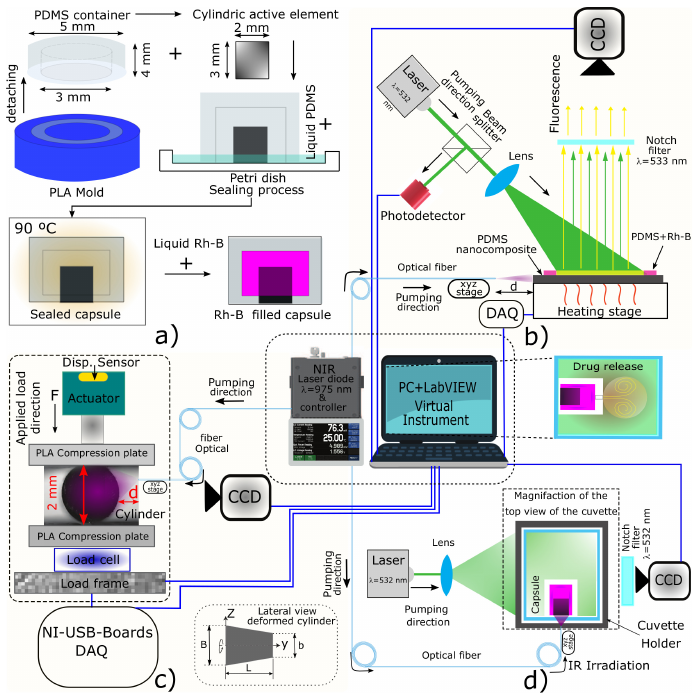
Figure 11. General overview of the different experimental setups to evaluate the photomechanical response of the nanocomposites: ( a ) device fabrication process and mold details; ( b ) laser-induced fluorescence thermometry (LIFT) measurements of the nanocomposites undergoing NIR irradiation; ( c ) NIR laser stress/strain-induced within the nanocomposites; and ( d ) drug release experiment triggered by a photomechanical